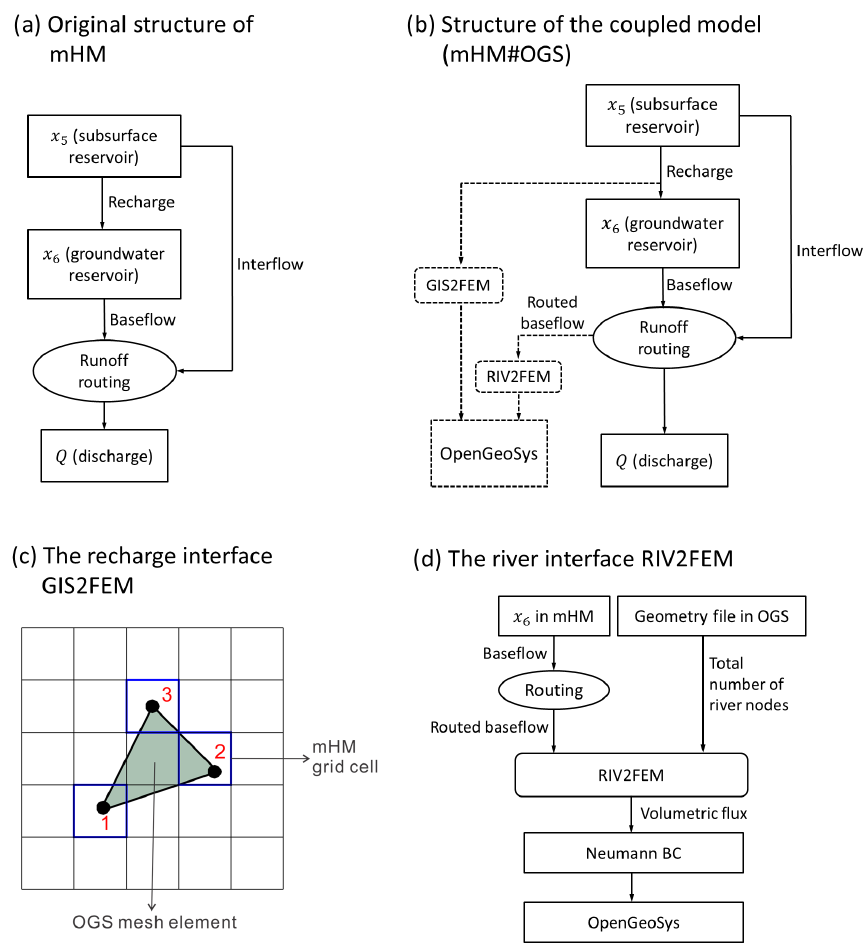
Figure 2. Schematic of the coupled model mHM–OGS v1.0. (a) Original structure of the vertically layered reservoir of mHM. (b) Structure of the coupled model (mHM–OGS v1.0). (c) Illustration of data interpolation and transformation through the coupling interface GIS2FEM. (d) Scheme of the river interface RIV2FEM. For the sake of simplicity, the figure only displays mHM layers relevant to this study and neglects the other mHM layers (i.e., x 1 − x 4 ). In (c) , the grid-based mHM fluxes (e.g., recharge) are linearly interpolated to the top surface of the OGS mesh and further transferred into volumetric values and directly assigned to the surface mesh nodes of the OGS